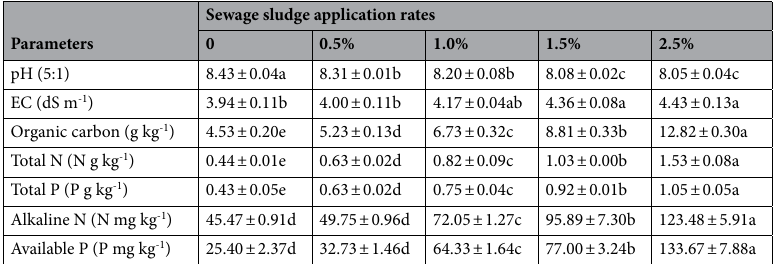
Table 2. Chemical properties of salt-affected mudflat soil at different sewage sludge application rates. Values are mean ± SD of three replicates. Different letters in each row indicate significant difference at p < 0.05 by LSD’s multiple range test.